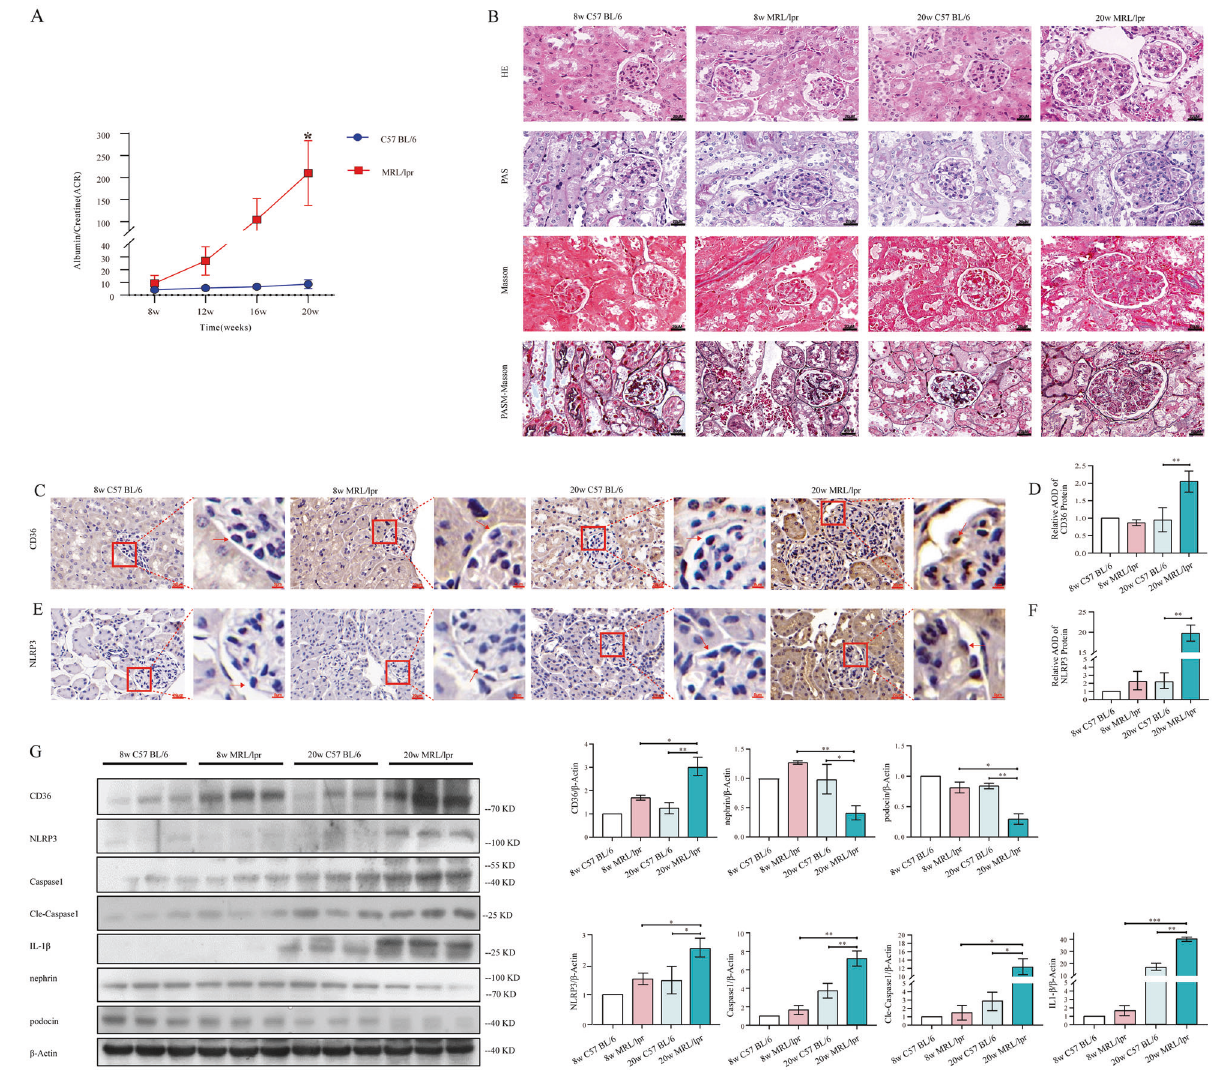
Fig. 2 The expression of CD36 and NLRP3 in fl ammasome was upregulated in MRL/lpr mice with renal impairment. A The urinary protein levels of C57 BL/6 and MRL/lpr mice were shown by urinary Albumin/Creatinine (uACR) (20w C57 BL /6 vs. 20w MRL/lpr). B Renal tissue sections were stained with HE, PAS, Masson, PASM-Masson to assess renal pathology (scale bar 20 μ m) (original magni fi cation: ×400). C – F Immunohistochemical staining showed the localization and relative quanti fi cation of CD36, NLRP3 protein in murine kidney (C57 BL/6 and MRL/lpr mice; scale bar 20 μ m and 5 μ m). The relative expression of protein was indirectly re fl ected by AOD value. The red arrow denoted the most prominent podocyte (original magni fi cation: ×400). G Quantitative expression of CD36, NLRP3, Caspase1, Cleaved-Caspase1, IL-1 β , Nephrin, Podocin, protein in renal tissue homogenate from C57 BL/6 and MRL/lpr mice was detected by western blot analysis (8w MRL/lpr vs. 20w MRL/lpr; 20w C57 BL/6 vs. 20w MRL/lpr). Cle-Caspase1: Cleaved-Caspase1. Data are expressed as the mean ± SD. * p < 0.05. ** p < 0.01. *** p <